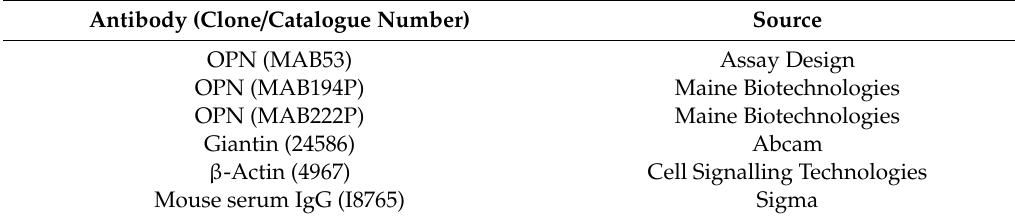
Table 1. Details of antibodies used in this